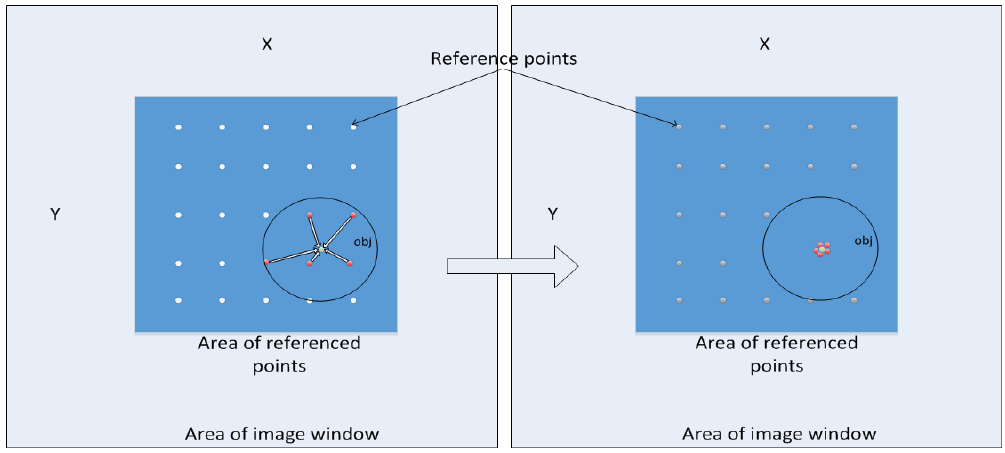
Figure 5. The principle of building a grid of output reference